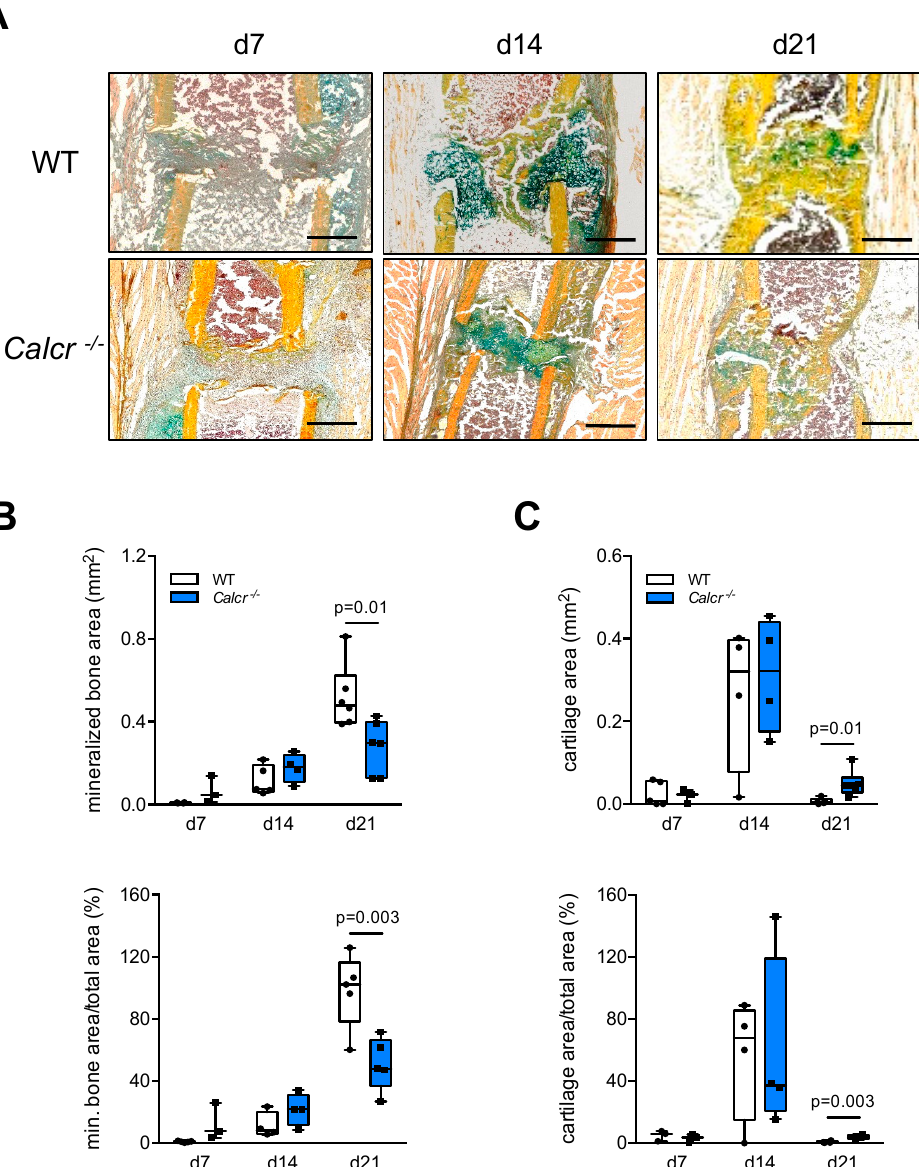
Figure 4. Slight alteration in callus remodeling in CTR-deficient mice. ( A ) Representative callus sections (Movat Pentachrome staining) of WT and CTR-deficient mice at the indicated time points following osteotomy (yellow = mineralized bone; green = cartilage; red = muscle). Scale bars = 500 µ m. ( B , C ) Histomorphometric quantification of static callus parameters in the same mice. n = 3–6 mice per group and time point as indicated. Box plots represent median with minimum and maximum whiskers.